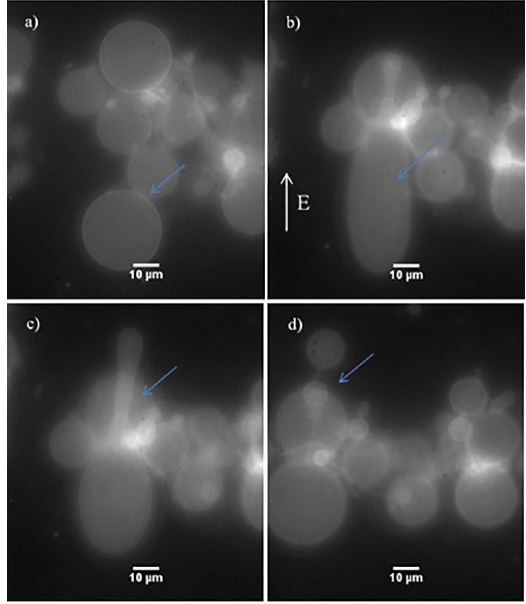
Figure 5. Sequence of optical fluorescence microscopy images of GUVs produced from DLPC and rhodamine: (a) absence of an electric field and after the addition of a concentrated glucose solution, (b) with applied electric field of 30 V/mm, 60 Hz and (c) and (d) with applied electric field of 4 V/mm, 60 Hz.